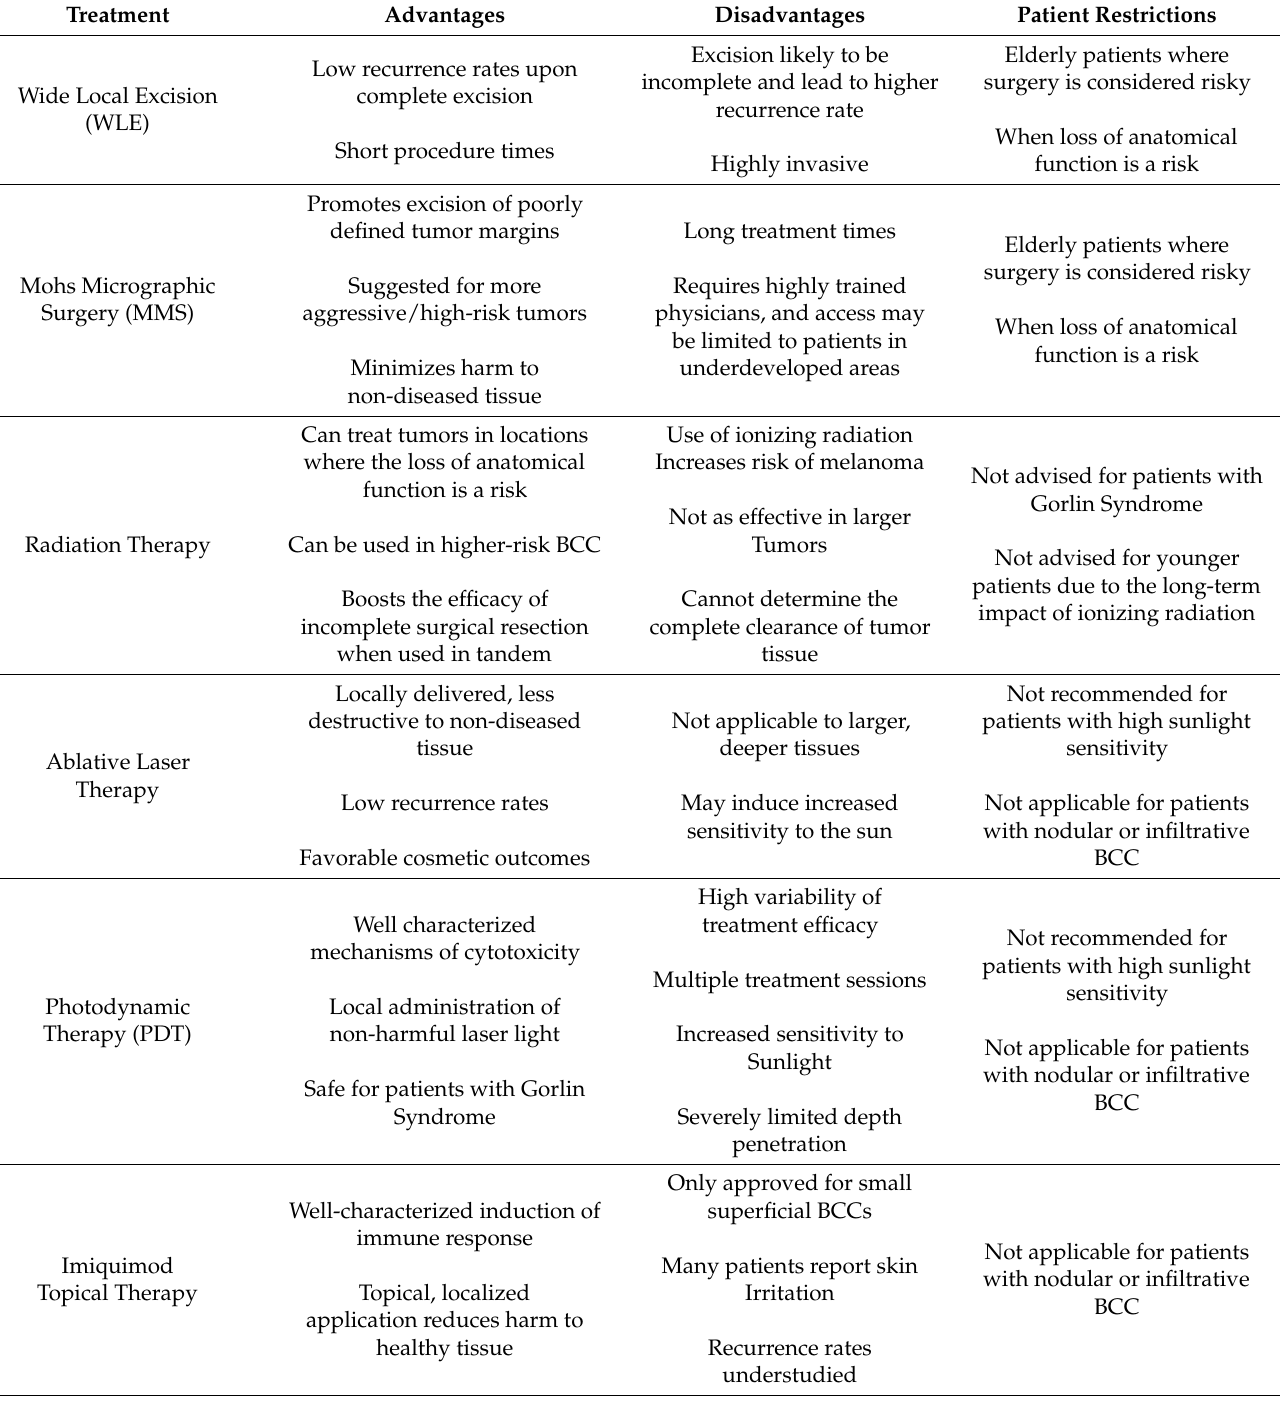
Table 1. Select list and commentary of treatment options for